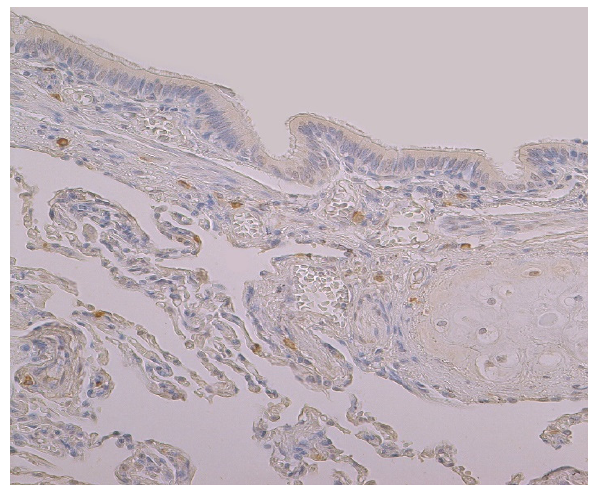
Figure 3. Immunohistochemical micrograph of occasional to few numbers of HBD-4 positive cells in connective tissue, cartilage and alveolar epithelium, but not in the bronchial epithelium of 74-year-old female. HBD-4 IMH, ×200.